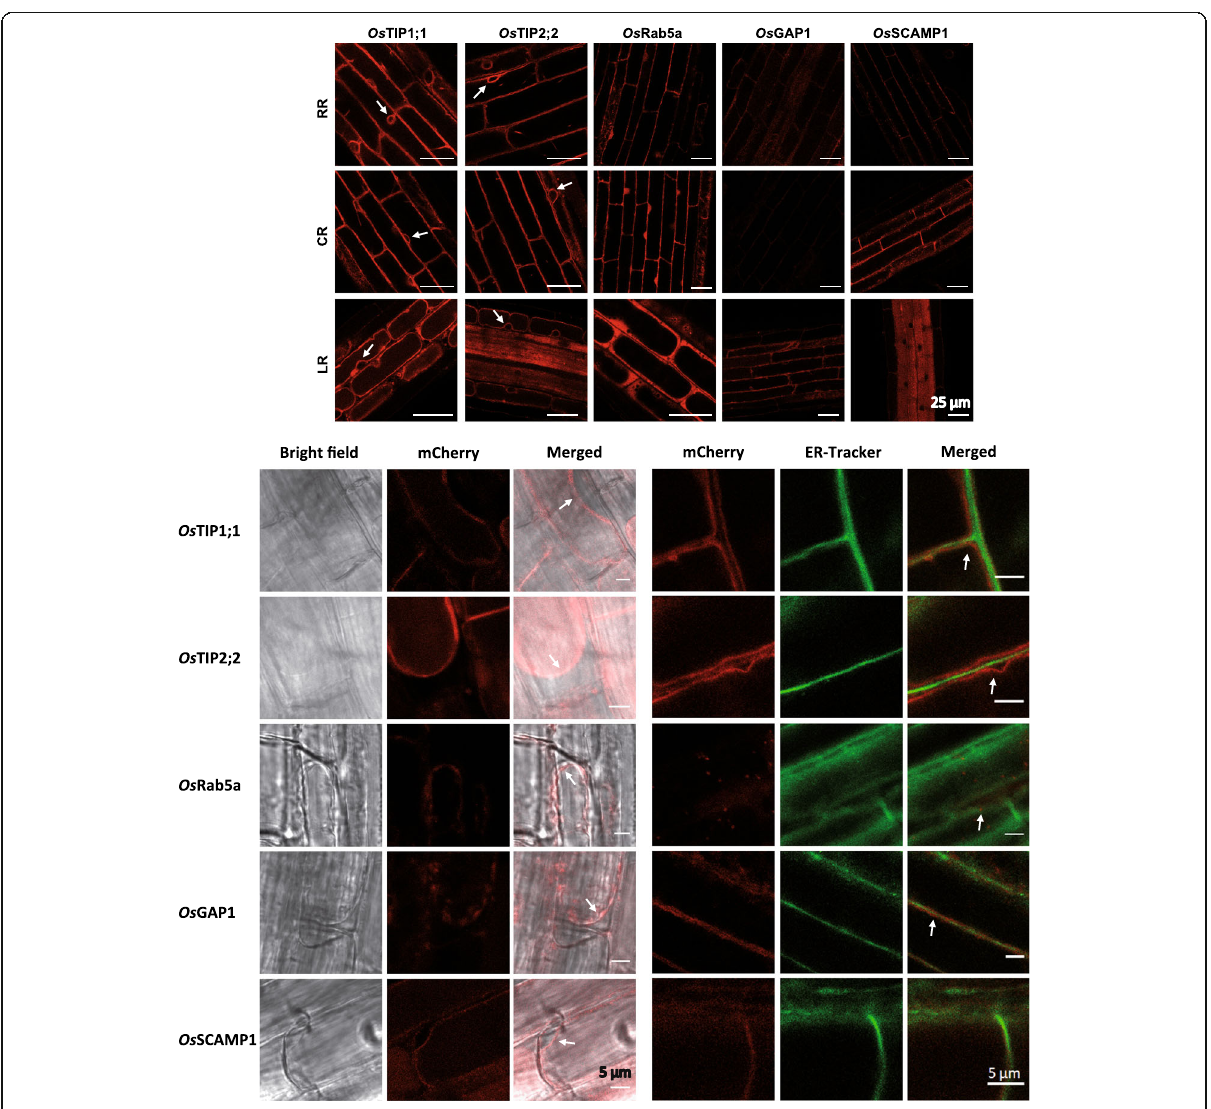
Fig. 2 Subcellular localization of intracellular protein markers tagged with fluorescent proteins in rice root. Labelling of mCherry-construction ( Os TIP1;1, Os TIP2;2, Os Rab5a, Os GAP1 and Os SCAMP1) was observed in exodermis of fresh roots in different types (upper). Note labelling of Os TIP-mCherry constructs that skirted the nuclei (arrows). Plasmolysis of protoplasts revealed a space between the labelling and the cell wall (arrows, lower left). ER-Tracker Blue-White DPX staining revealed in most of the case no colocalization with mCherry-constructs (arrows, lower